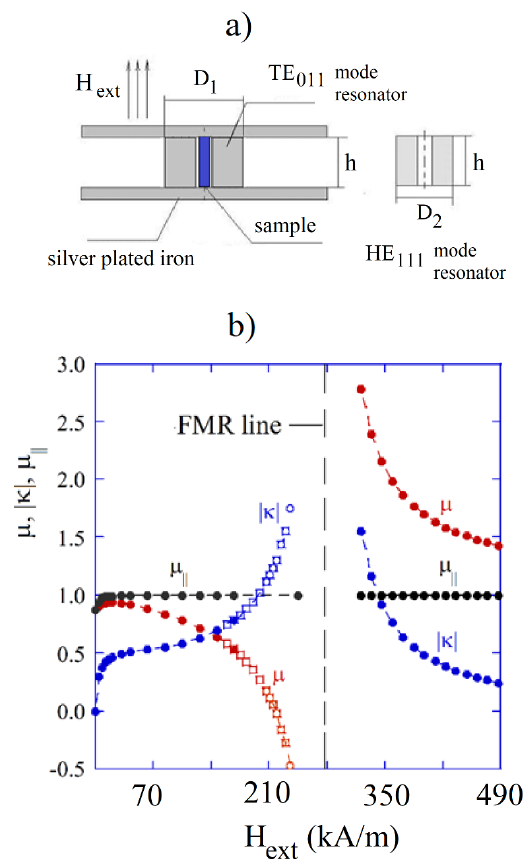
Figure 14. ( a ) Two dielectric resonators for measurements of permeability tensor. ( b ) Results of measurements of three permeability tensor components of polycrystalline YIG scaled to frequency 9.82 GHz, dots refer to the sample having a diameter of 2.00 mm, squares refer to the sample having d = 0.47 mm [67].